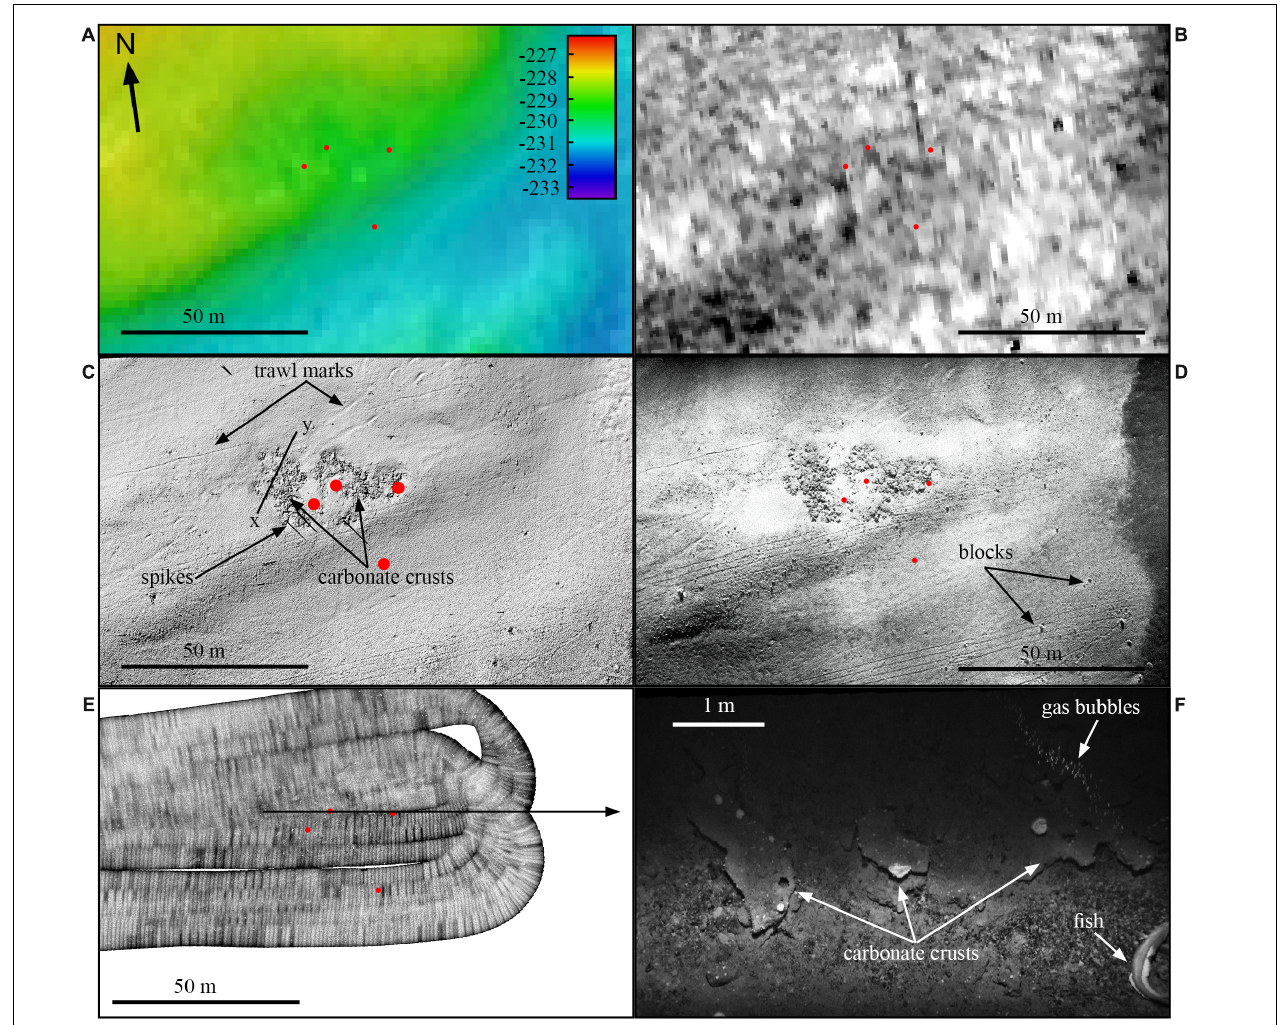
FIGURE 4 | Examples of different sensors from a subsection in Area 1 – see Figure 5 for location. (A) Ship-based multibeam bathymetry. Red dots show gas flares. (B) Ship-based backscatter. High backscatter – lighter tones, low backscatter – darker tones. (C) Hillshade image, based on AUV SAS micro-bathymetry, with profile line (x–y) for Figure 6 . (D) AUV-based SAS imagery. (E) AUV-based photo mosaic. Striping is due to level differences between individual photos. (F) Single photo from AUV. Note carbonate crusts and gas